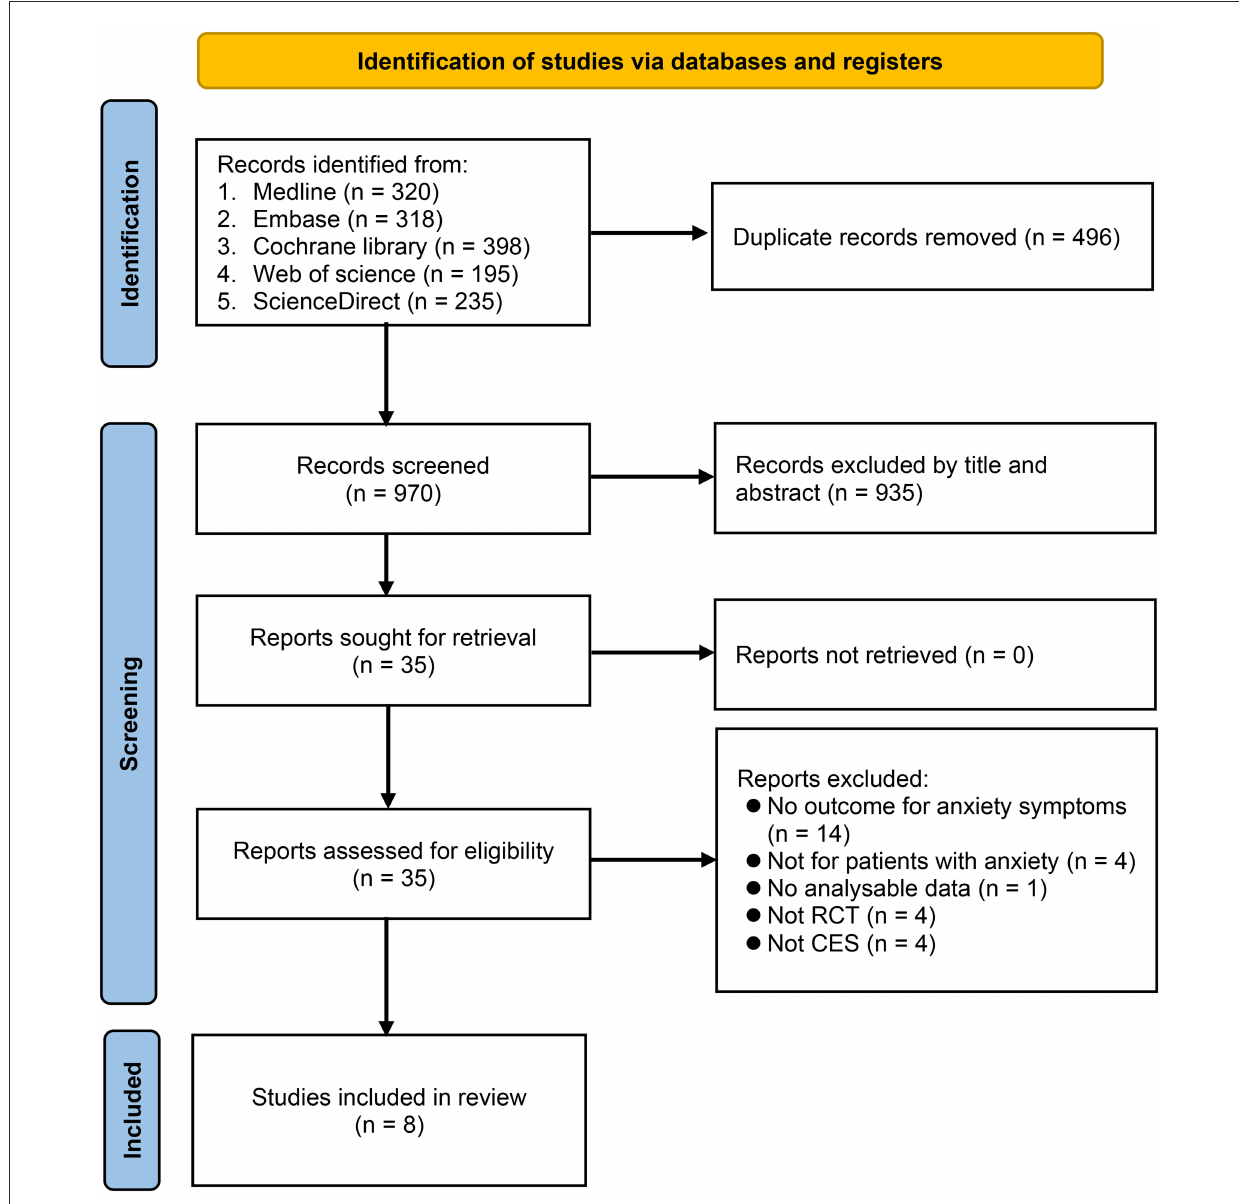
FIGURE1 Flowchart for study selection. CES, cranial electrical stimulation; RCT, randomized controlled trial.